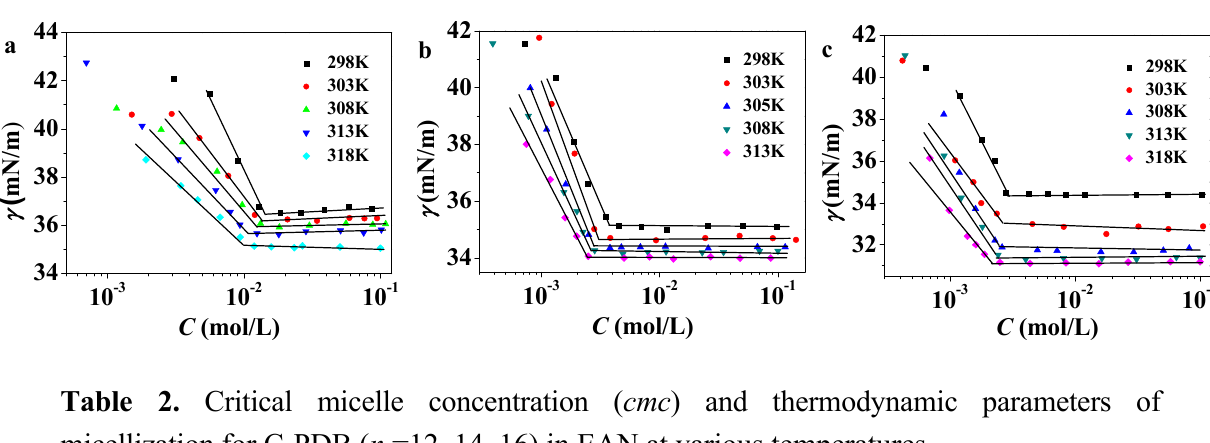
Figure 3. Surface tensions versus concentration at different temperatures of C 12 PDB ( a ); C 14 PDB ( b ); C 16 PDB ( c ) in EAN.